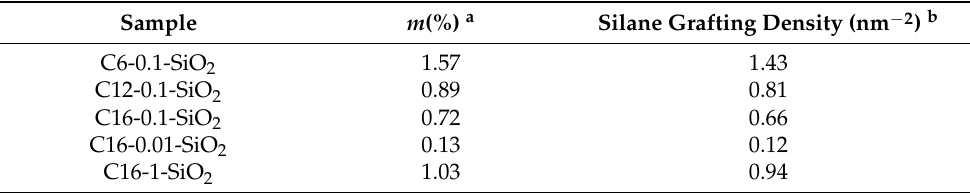
Table 1. Silane grafting amounts derived from